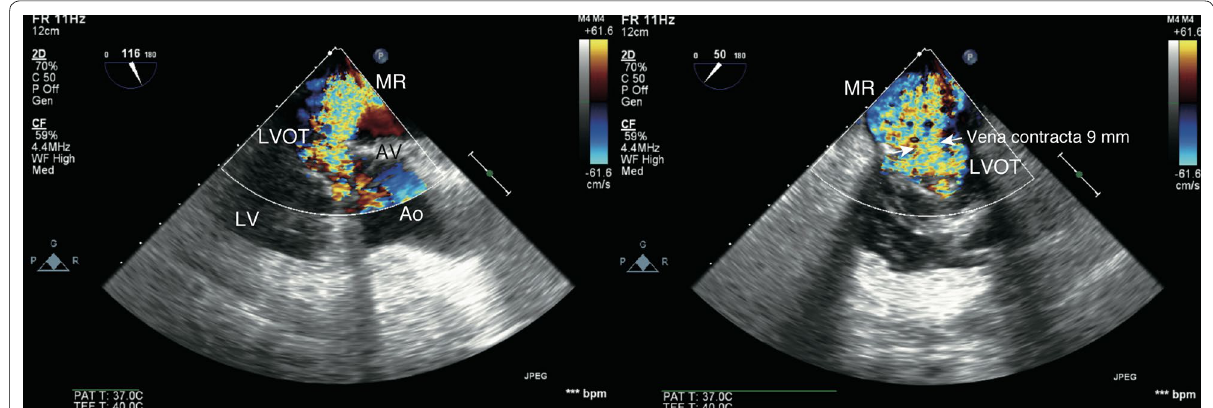
Fig. 1 Massive mitral regurgitation and turbulent flow in the left ventricular outflow tract. MR mitral regurgitation, LVOT left ventricular outflow tract, Ao ascending aorta, AV aortic valve, LV left